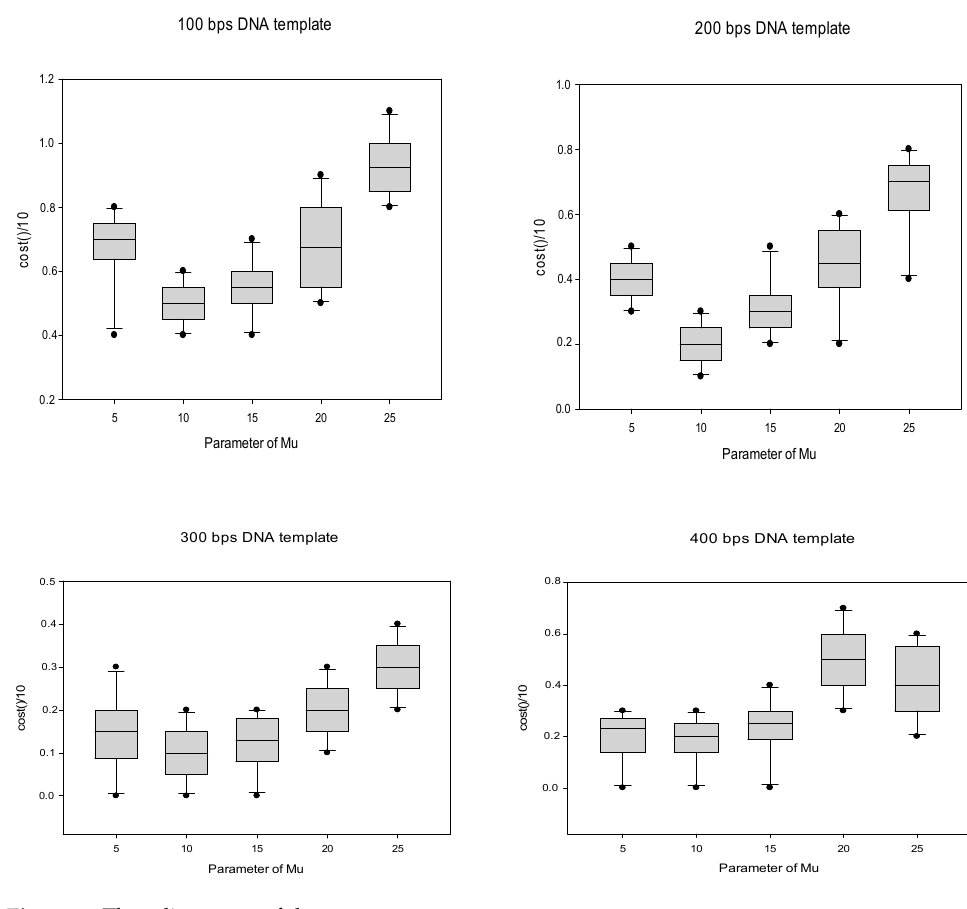
Figure 4. The adjustment of the parameter µ